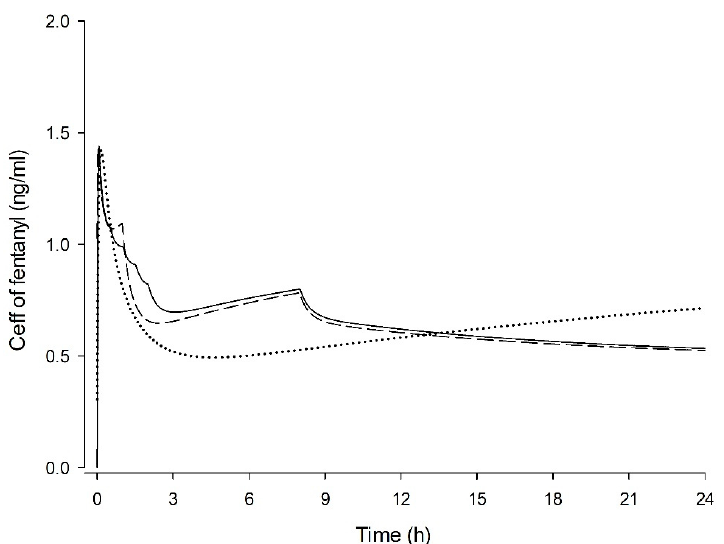
Figure 3. Time-courses of predicted effect-site concentration (C eff ) of fentanyl with the three background infusions (BI) without patient-controlled analgesia (PCA) demand-dose after intravenous injection of fentanyl 0.5 μ g/kg at time 0 h. CRBI group (dotted line), fentanyl PCA with constant rate BI; TDBI group (dashed line), fentanyl PCA with time-scheduled decremental BI; POBI group (solid line), fentanyl PCA with PCA-optimised BI.